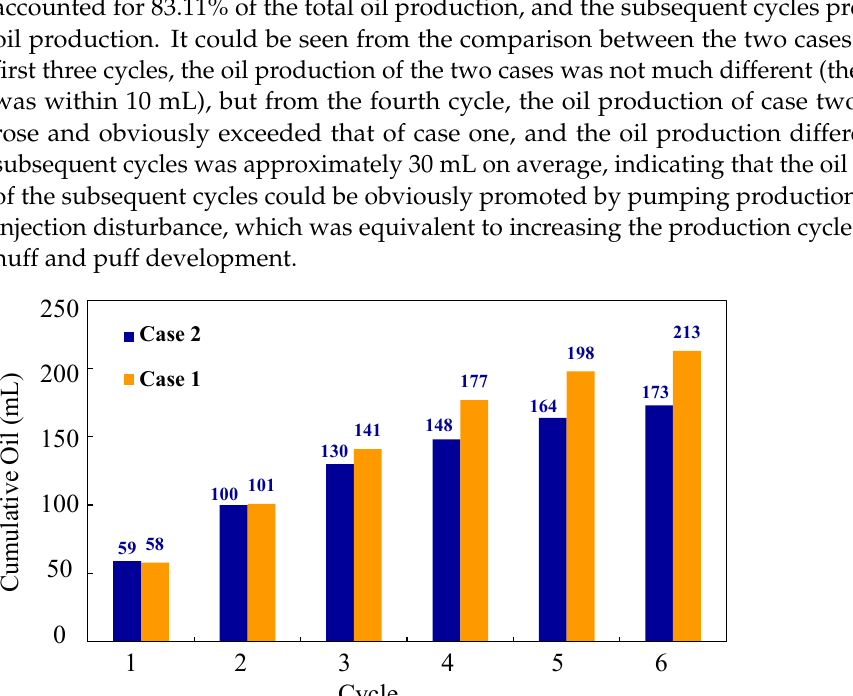
Figure 9. Cumulative oil production of case one and case two.